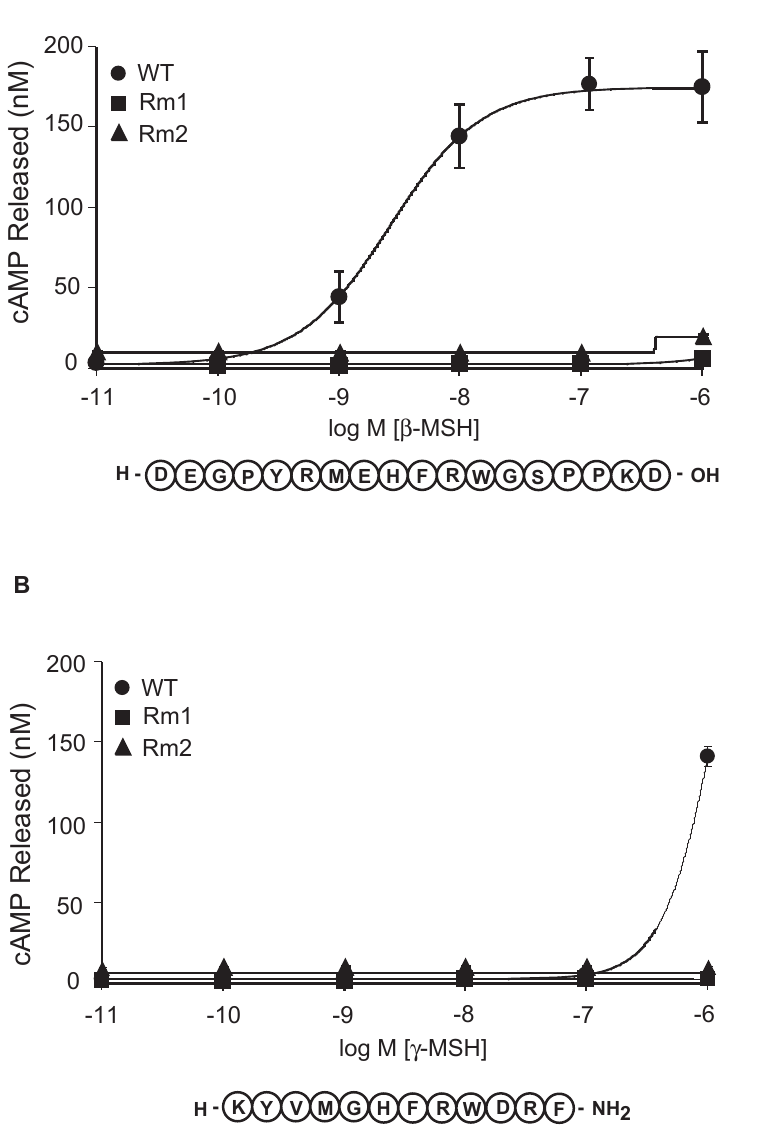
Figure 5. Wild-type MC4R, Rm1, and Rm2 were transiently transfected into HEK293 cells, which were stimulated with increasing concentrations of b -MSH (A) or of c -MSH (B), and cAMP was measured to generate dose-response curves. Data shown are mean 6 s.e.m. of quadruplicate determinations. The dose-response curves are representative of two independent experiments.